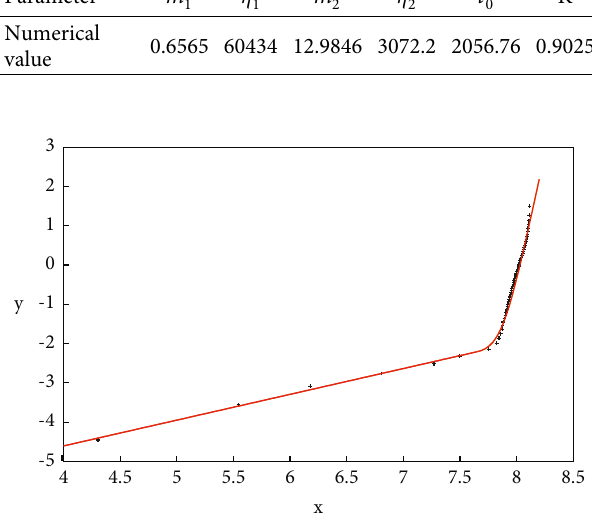
Figure 9: Fitting effect diagram of genetic